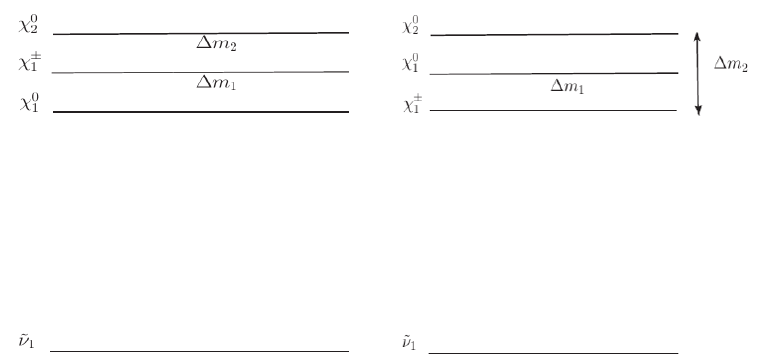
Figure 3 . Schematic description of the mass spectrum with j M 1 j ; M 2 (cid:29) j (cid:22) j , and m ~ (cid:23) j m j (cid:0) m = (cid:1) m 2 ; m (cid:0) j m j = (cid:1) m 1 ~ (cid:31) 0 2 ~ (cid:31) 0 1 ~ (cid:31) (cid:6) 1 ~ (cid:31) (cid:6) 1